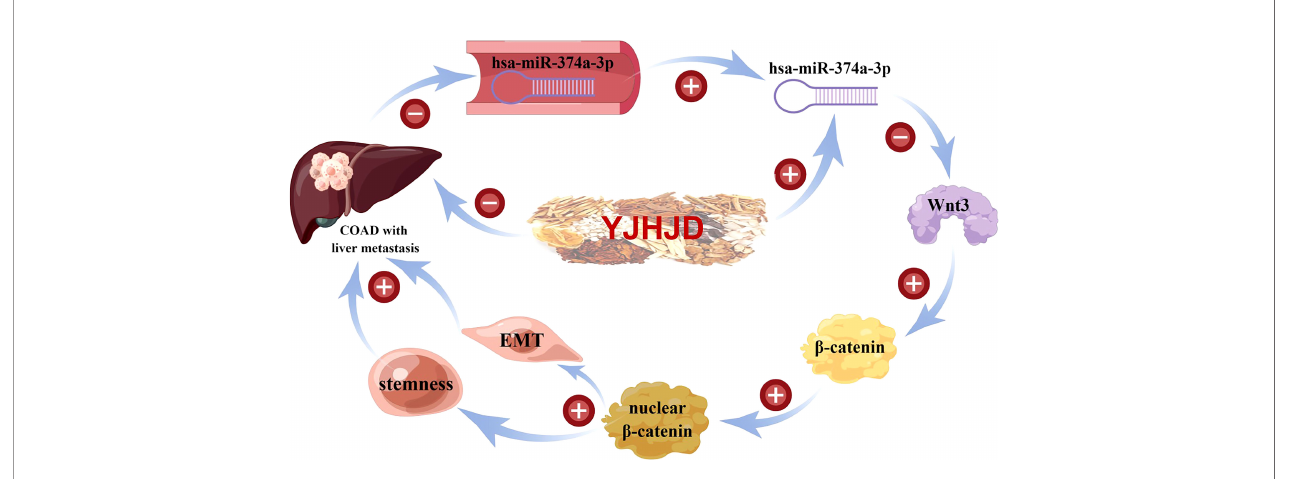
FIGURE 8 | Mechanism fl owchart of the effect of YJHJD